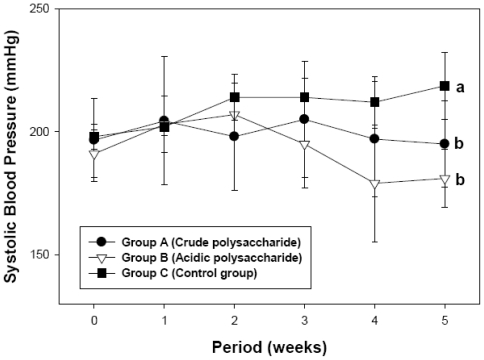
Effects of crude and acidic polysaccharides of Gastrodia rhizome on blood pressure after 5 weeks of treatment. * p < 0.05 indicates statistically significant different to only control group (Group C); also data are presented as the mean ± standard deviation of twelve experiments in each group.